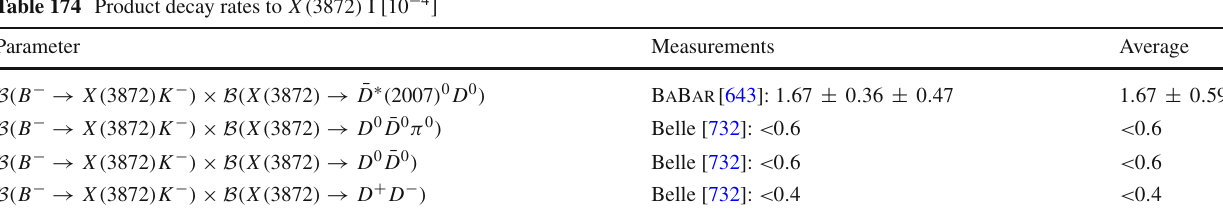
Table 174 Product decay rates to X ( 3872 ) I [ 10 − 4 ]